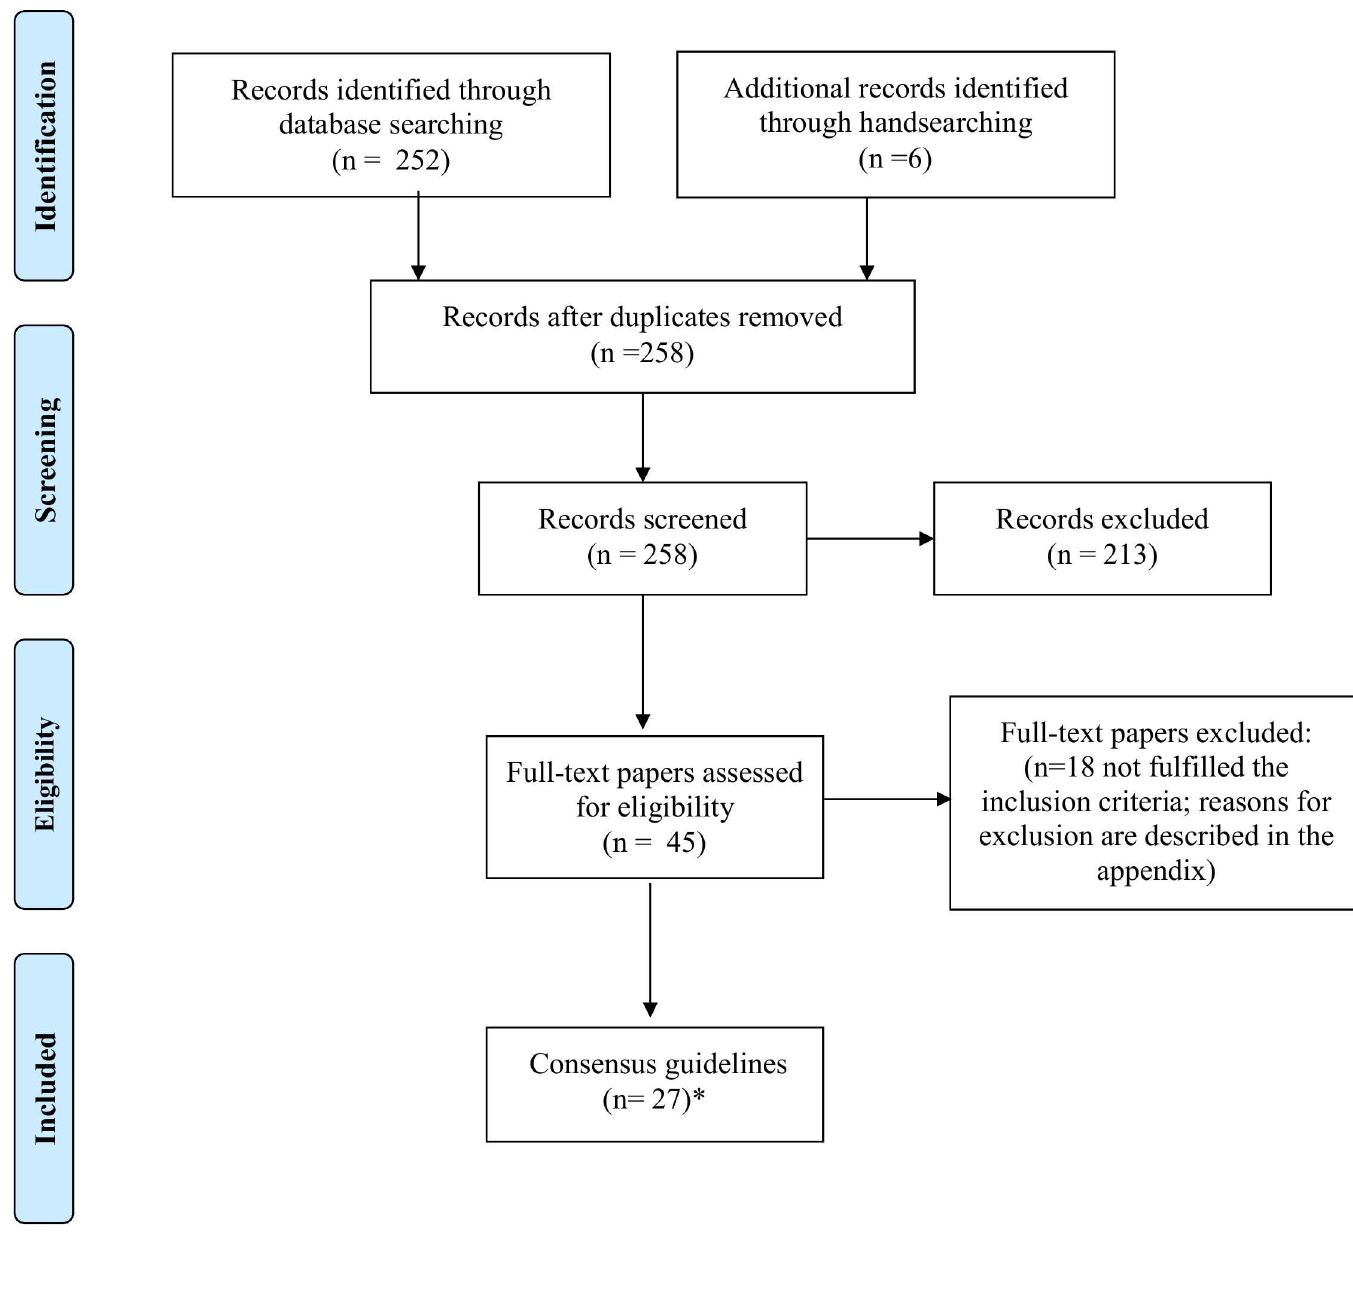
Fig 1. PRISMA-style flow diagram of the consensus guidelines search